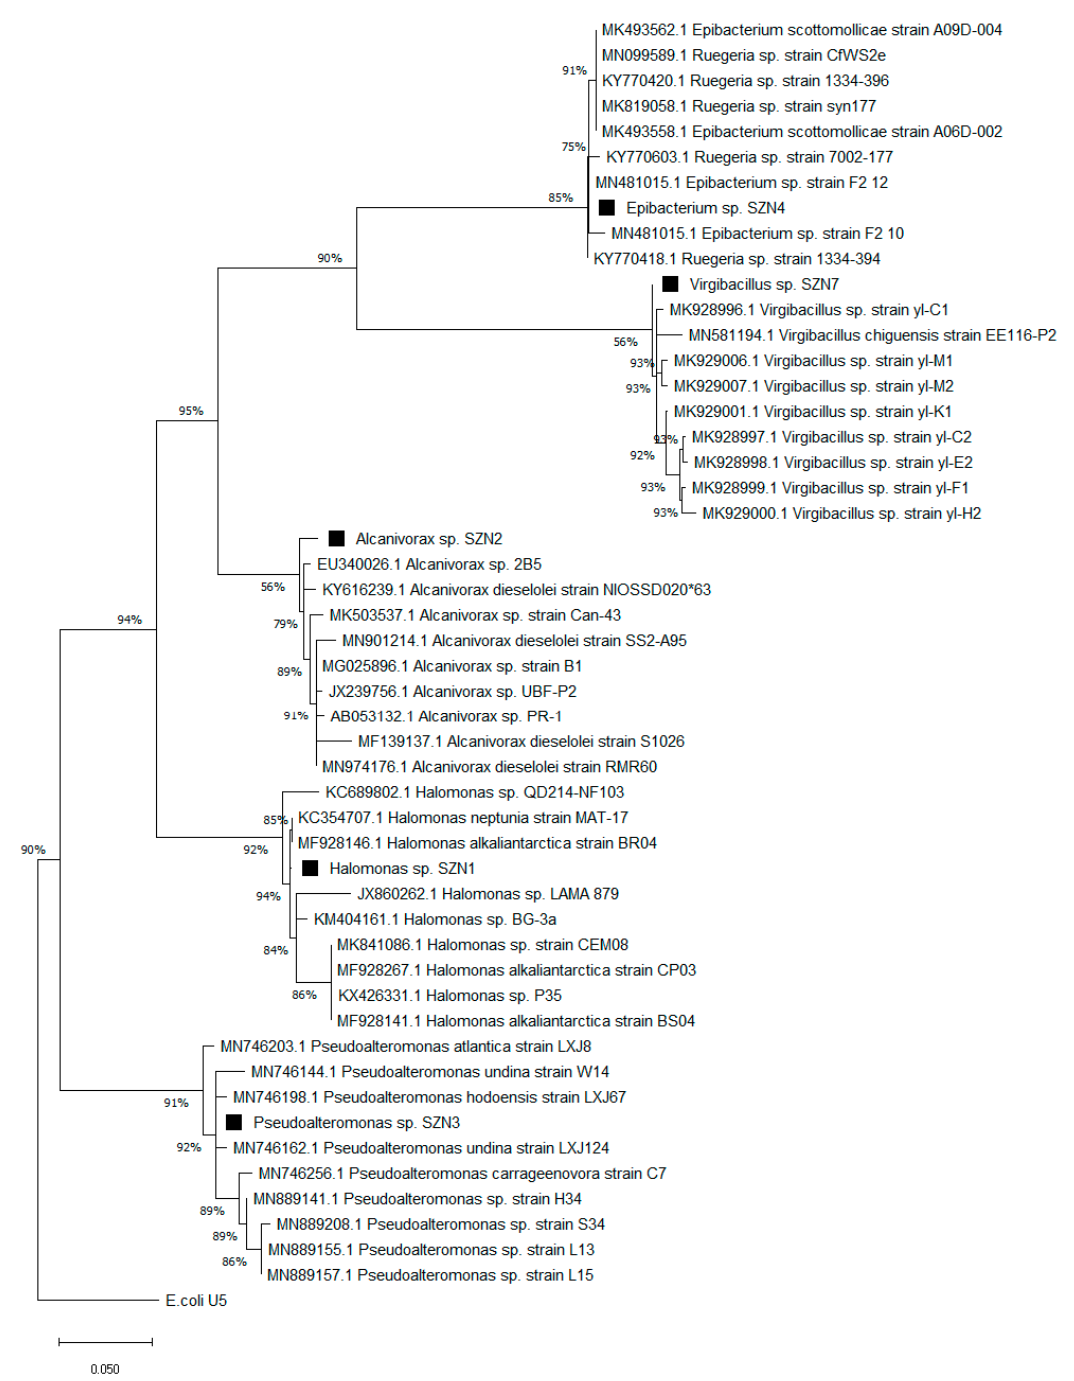
Figure 2. Maximum likelihood tree of the 16S rRNA gene sequences of the five cultured taxa isolated from Bagnoli–Coroglio sediments ( Halomonas sp. SZN1, Alcanivorax sp. SZN2, Pseudoalteromonas sp. SZN3, Epibacterium sp. SZN4, and Virgibacillus sp. SZN7) and their closest cultured representatives with validly published names. For phylogeny test and tree construction, MEGA 7 was used [25]. Scale bar indicates 0.05 substitutions per position.